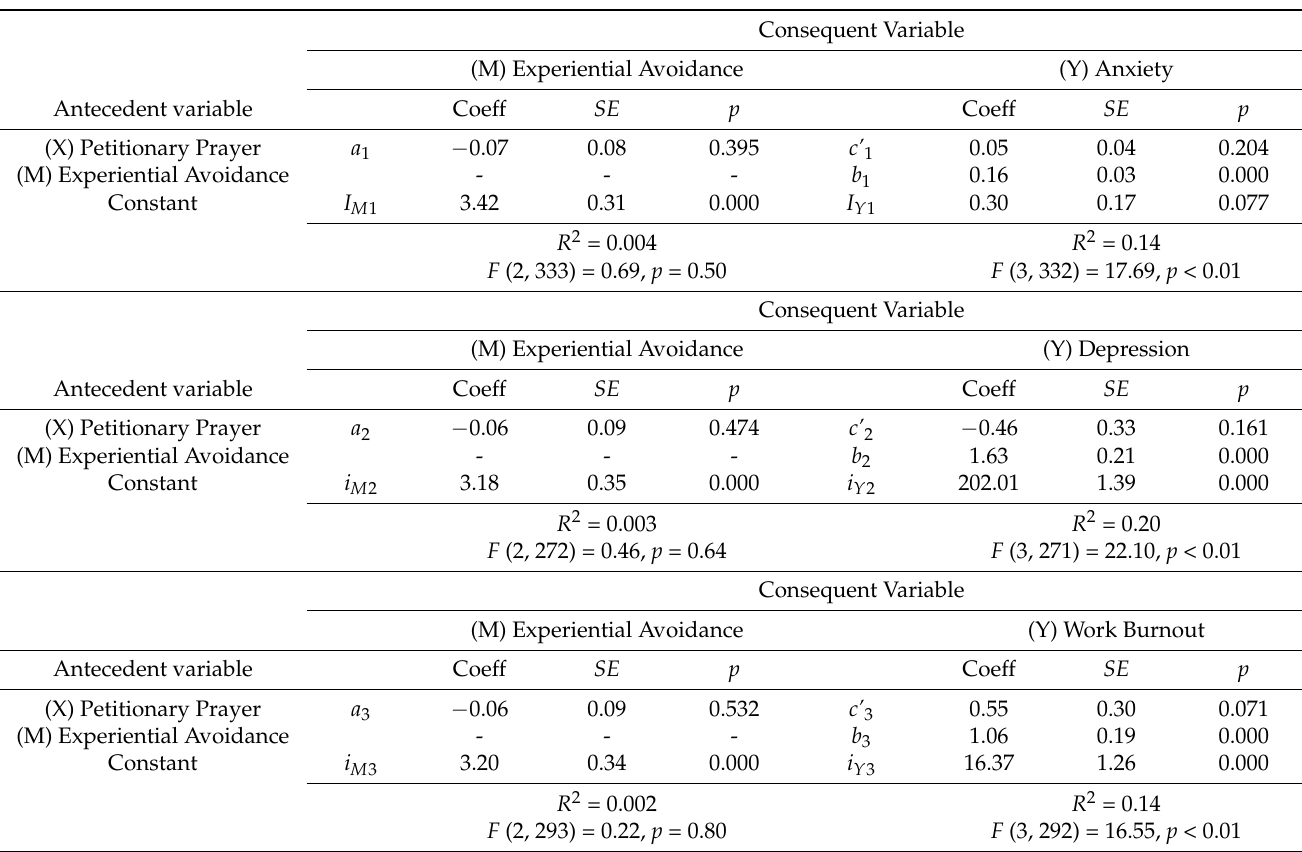
Table 7. Regression models involving petitionary prayer, experiential avoidance, and mental health